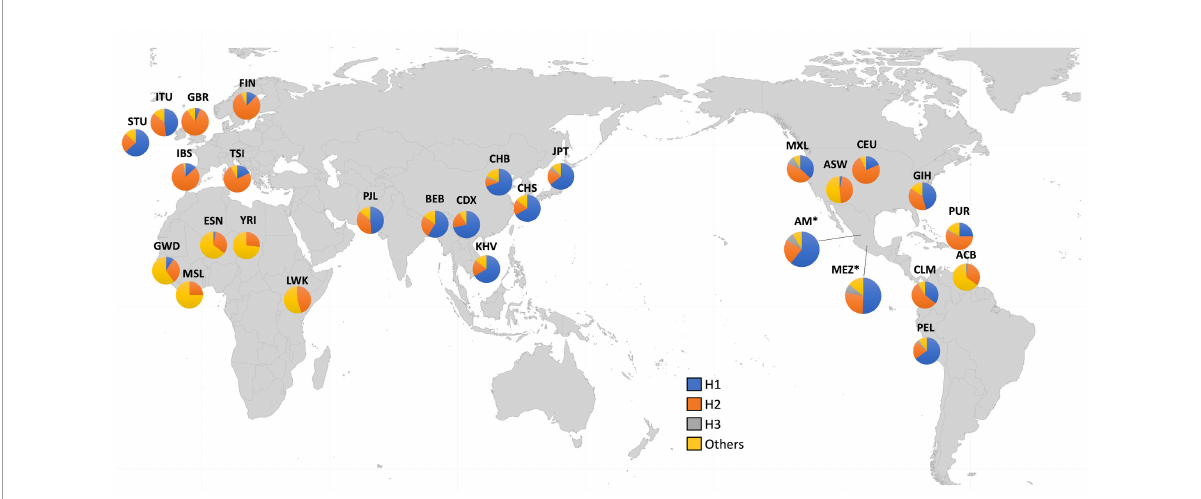
FIGURE2 Worldwide frequencies of Xq28 haplotypes. Haplotype H1–H3 frequencies are represented for each of the included 1KGP phase 3 populations.